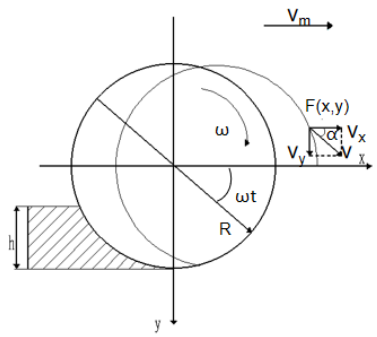
Figure 3. Analysis of ditching tool end point motion. R — Drenching knife disc end point gyration radius, m; t — Time, s; v m — Trencher forward speed, km/h; ω — Knife shaft angular speed,